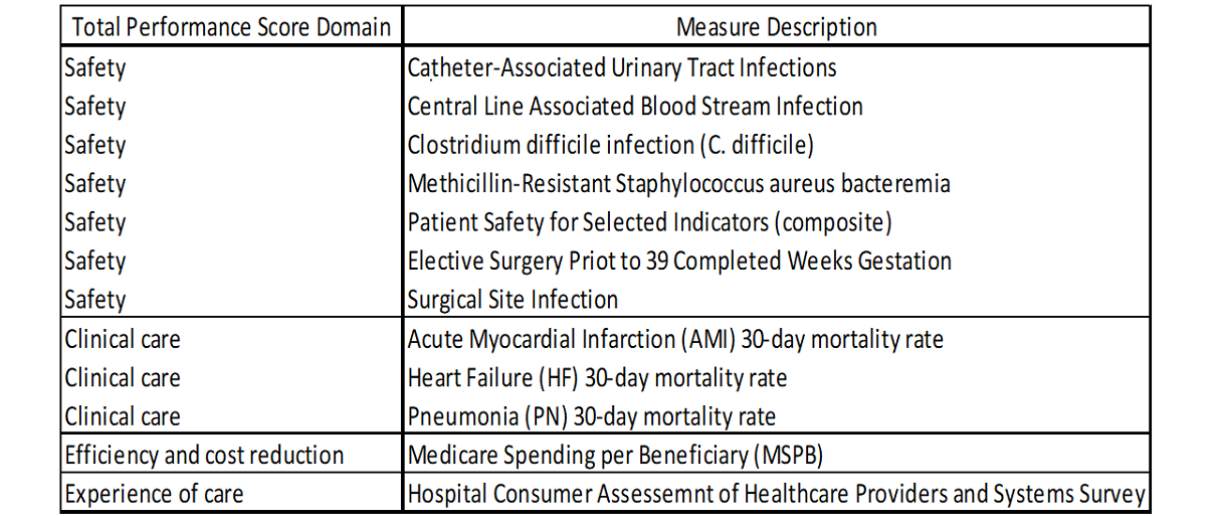
Figure 1. Financial year 2018 Hospital Value–Based Purchasing program